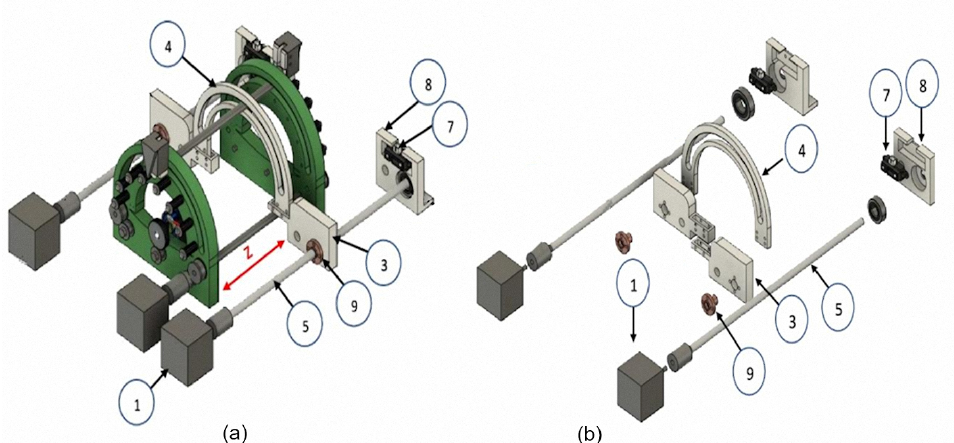
Figure 3. 3D model of the stereotactic positioning system. ( a ) Z-axis and the available length to displace the antenna, ( b ) exploded view of the stereotactic positioning system for displacement in the Z-axis, showing the parts used for the assembly. The stepper motor (1) was coupled one side to the spindle (5), the remaining end was placed in a holder (8), maintaining the line stability and avoiding deformation when the weight is concentrated in some of the ends of the spindle. A piece that will hold the auxiliary stereotactic arc (4) was placed on the spindle, this piece (3) has a space to place a toothed nut (9), and this allows it to move over the length of the spindle. An infrared sensor (7) was placed on the spindle (8) to monitor the displacement in the Z-axis.